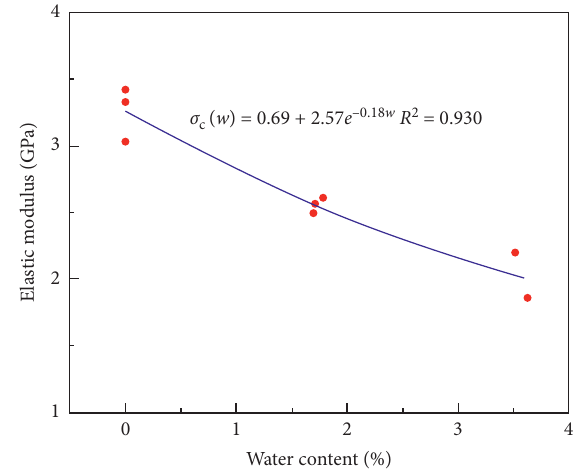
Figure 6: The relation between elastic modulus and water